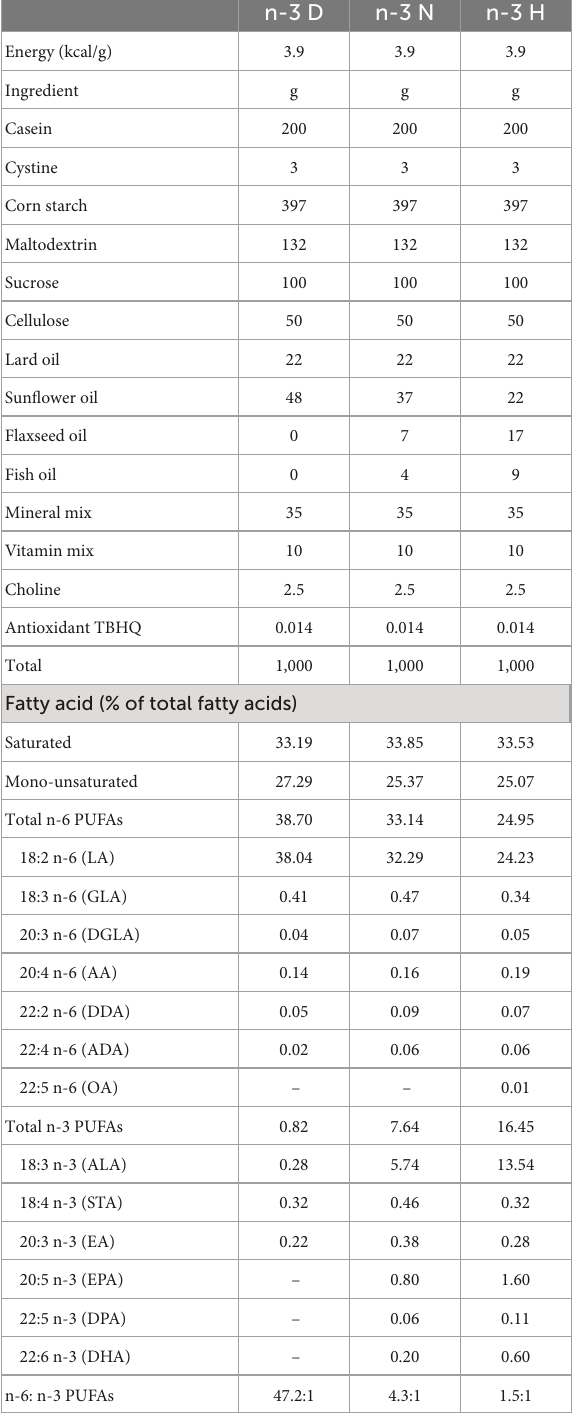
n-3 PUFAs, polyunsaturated fatty acids; LA, linoleic acid; GLA, γ -linoleic acid; DGLA, dihomo- γ -linolenic acid; AA, arachidonic acid; DDA, decanedicarboxylic acid; ADA, adrenic acid; OA, osbond acid; ALA, α -linolenic acid; STA, stearidonicacid; EA, eicosatrienoic acid; EPA, eicosapentaenoic acid; DPA, docosapentaenoci acid; DHA, docosahexaenoicacid;n-3D,n-3PUFA-deficientdiet;n-3N,normaln-3PUFAcontent